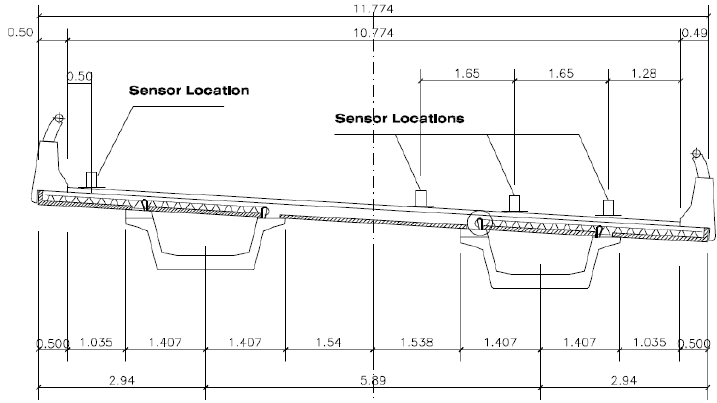
Figure 2. Cross section B1-B1 of the bridge, as indicated in Figure 3 (units in meters).